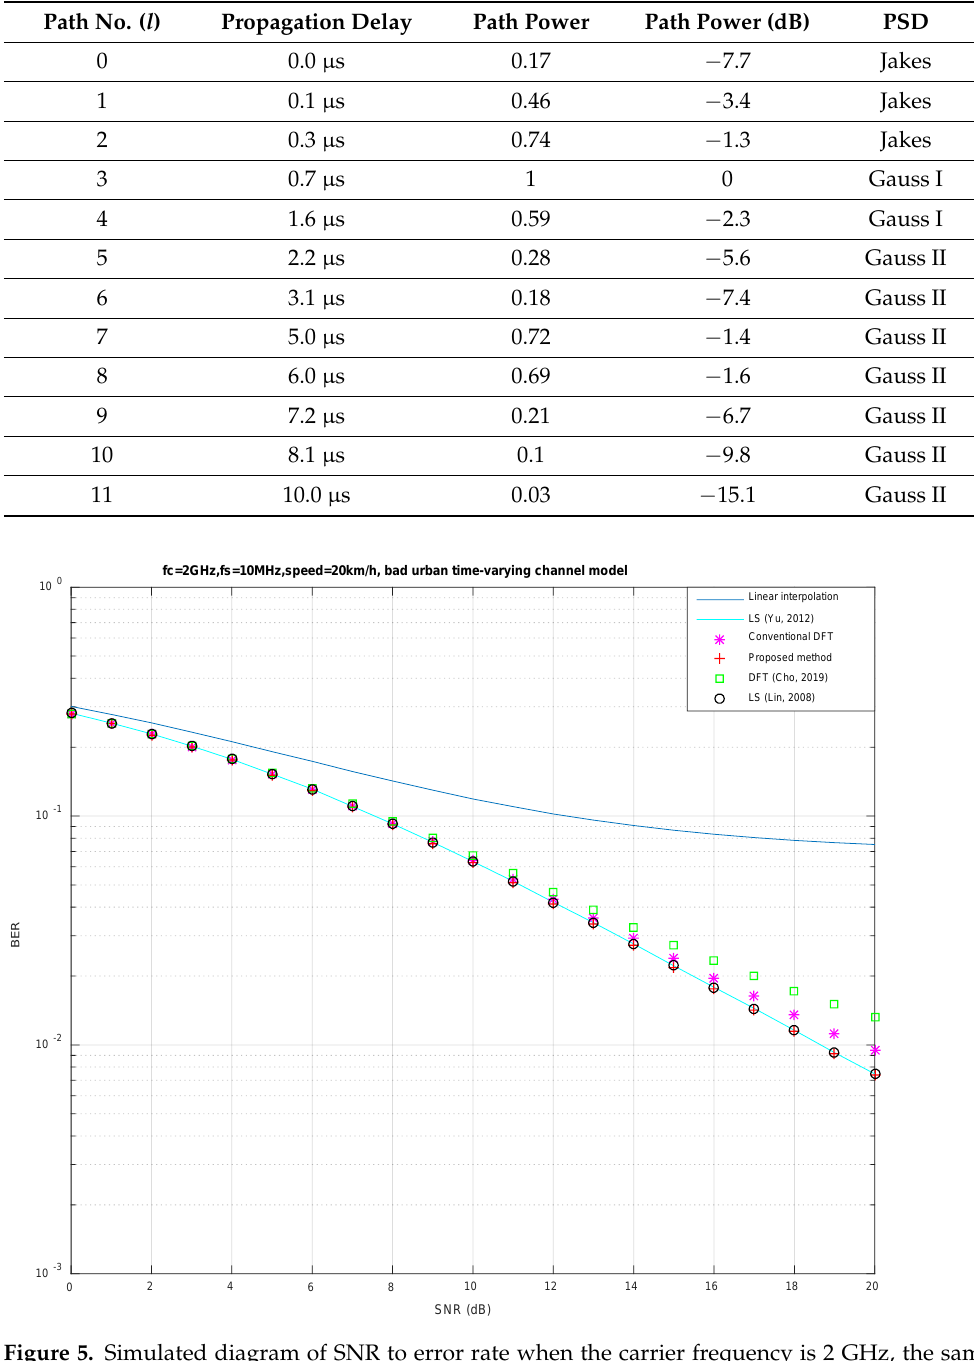
Figure 5. Simulated diagram of SNR to error rate when the carrier frequency is 2 GHz, the sampling frequency is 10 MHz, and the speed is 20 km/h for the bad urban time-varying channel model [8,10,11].